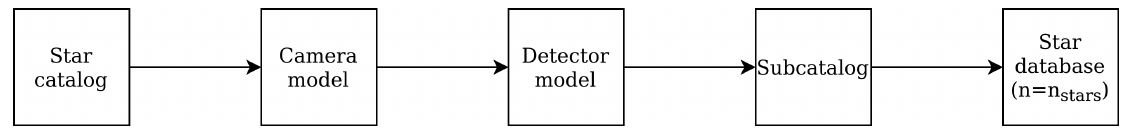
Figure 3. Database